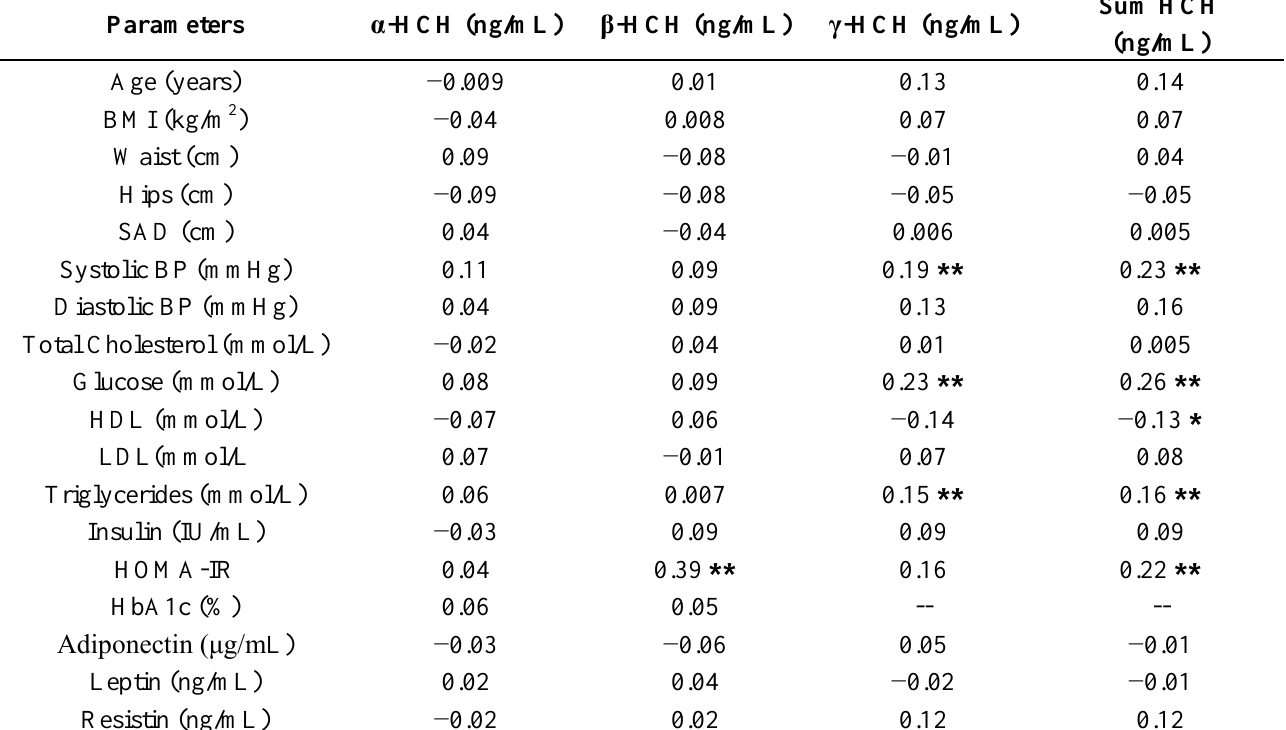
Table 2. Spearman correlation coefficients among wet-weight and lipid-standardized serum concentrations of organochlorine pesticides in